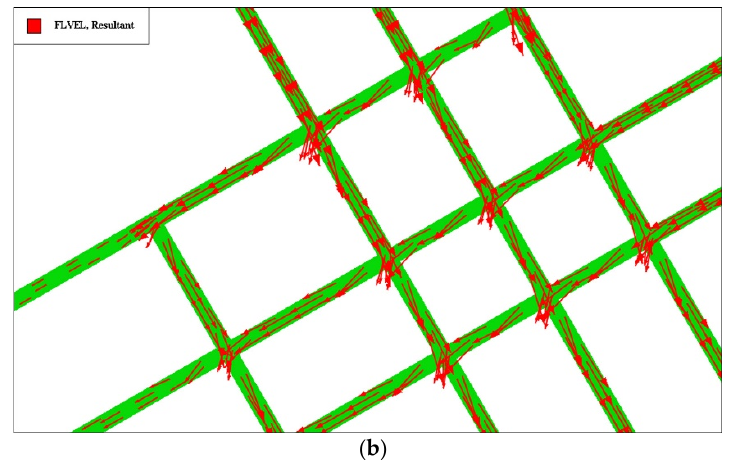
Figure 18. ( a ) The contour of the velocity; ( b ) the vector diagram of the velocity.